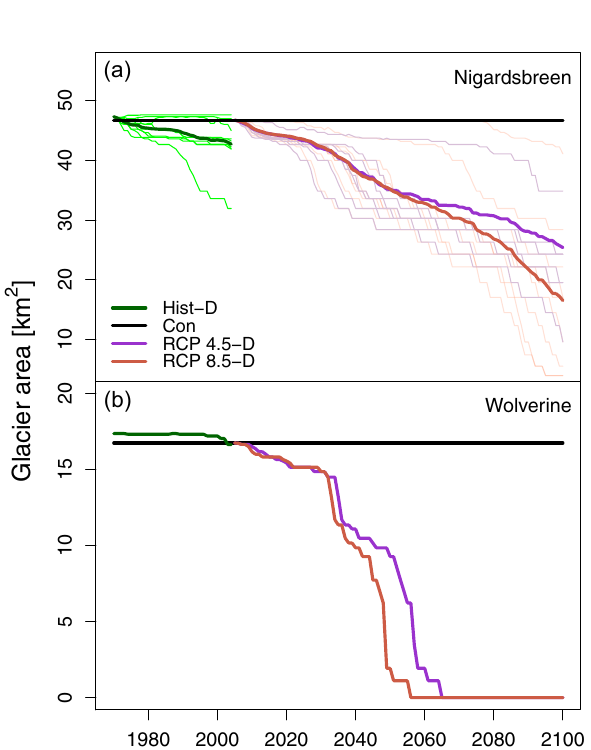
Figure 5. Temporal evolution of glacier areas for the historical and future periods. Panel (a) shows the glacier areas for Nigardsbreen and (b) for Wolverine. The glacier area in both glacier conceptu- alisations is shown. The lighter coloured lines in the Nigardsbreen graph for the historical period and the two RCP scenarios show the results of glacier area evolution for the different climate model forc-